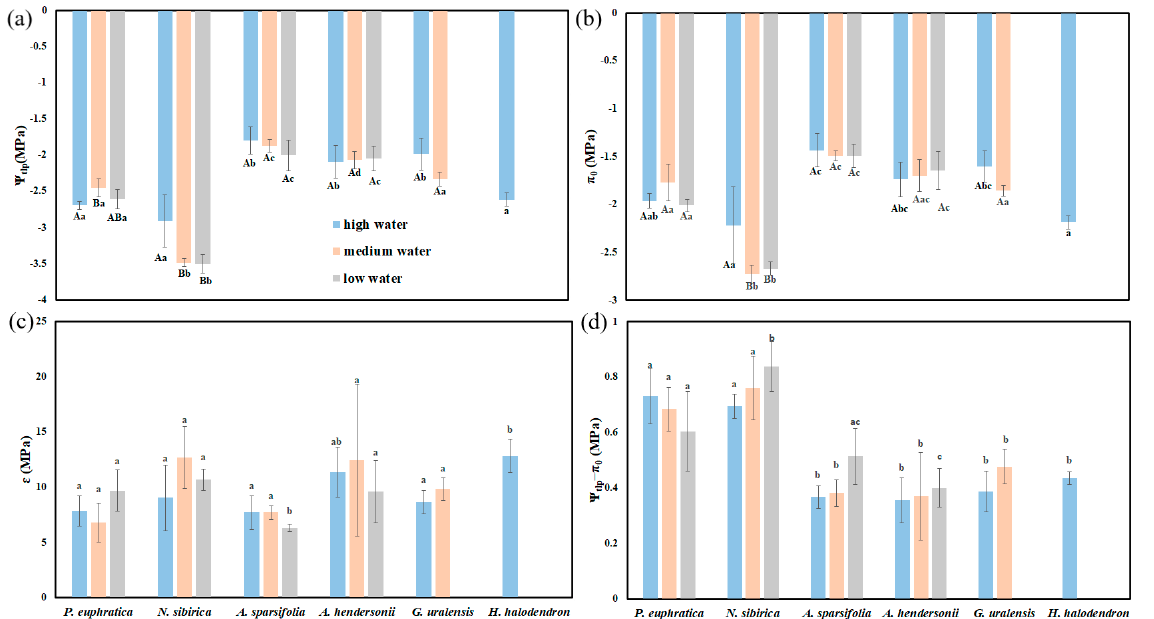
Figure 6. The differences in hydraulic parameters between water gradients and species. ( a ) The difference in the turgor loss point ( Ψ tlp ); ( b ) the difference in the saturated osmotic potential ( π 0 ); ( c ) the difference in the elastic mudulus ( ɛ ); ( d ) the difference in osmotic adjustment ability ( Ψ tlp −π 0 ). Different lowercase letters indicate significant differences between species, and different uppercase letters indicate significant differences between water gradients (mean + SE; N = 4), α = 0.05.